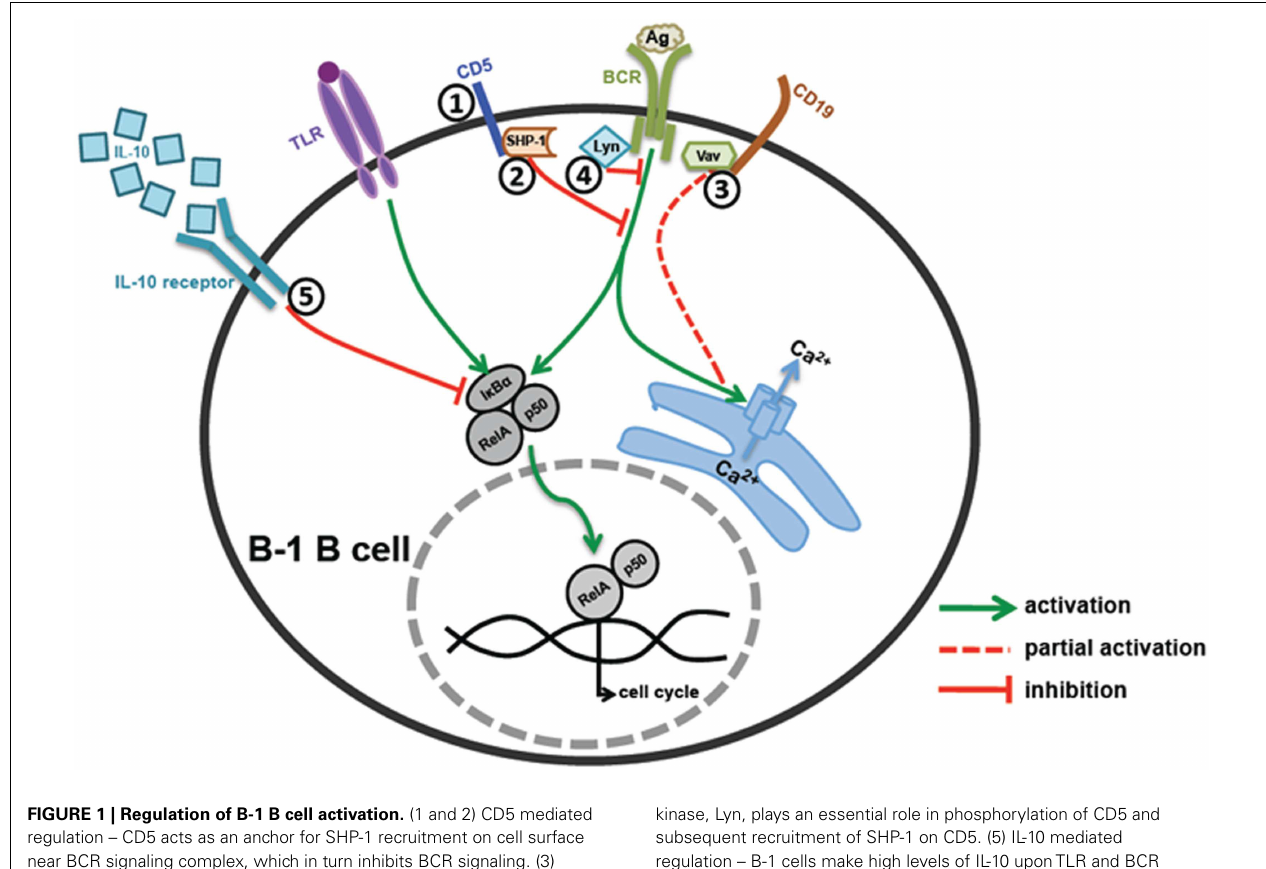
FIGURE 1 | Regulation of B-1 B cell activation. (1 and 2) CD5 mediated regulation – CD5 acts as an anchor for SHP-1 recruitment on cell surface near BCR signaling complex, which in turn inhibits BCR signaling. (3) CD19 mediated regulation – B-1 cells have defectiveVav recruitment to CD19 leading to reduced Ca2 + mobilization and cell activation upon BCR co-stimulation. (4) Src family kinase mediated regulation – Src family